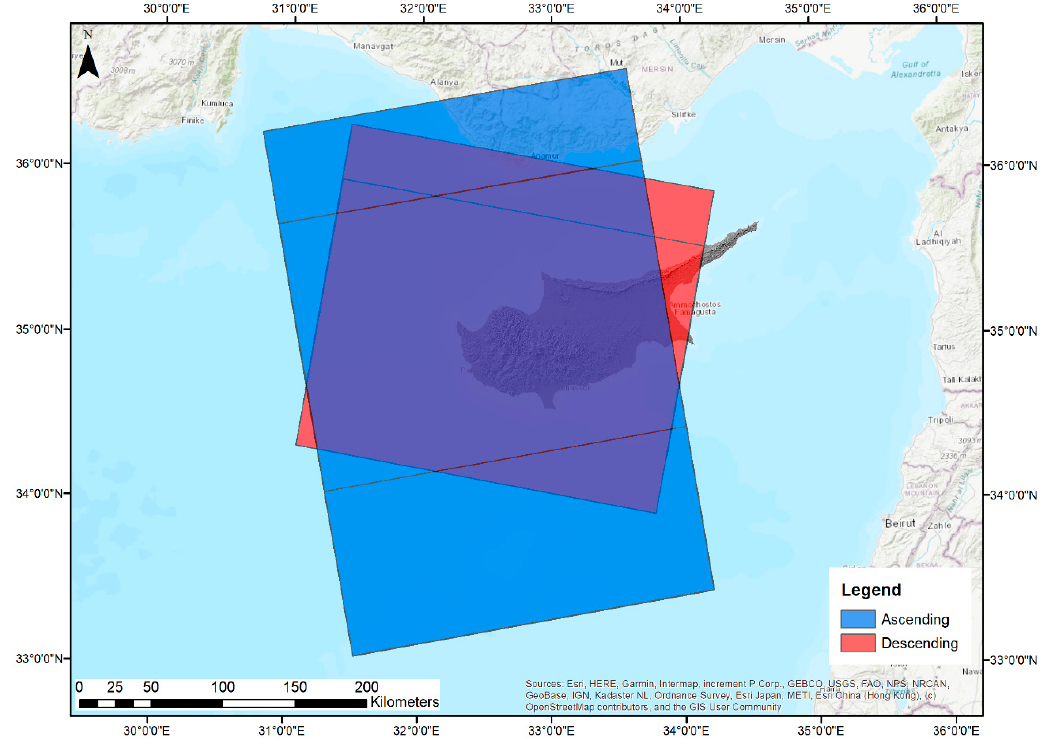
Figure 7. Sentinel-1 Synthetic Aperture Radar (SAR) acquisitions—11 January 2019–12 April Table 1. Synthetic Aperture Radar (SAR) image interferometric pairs.